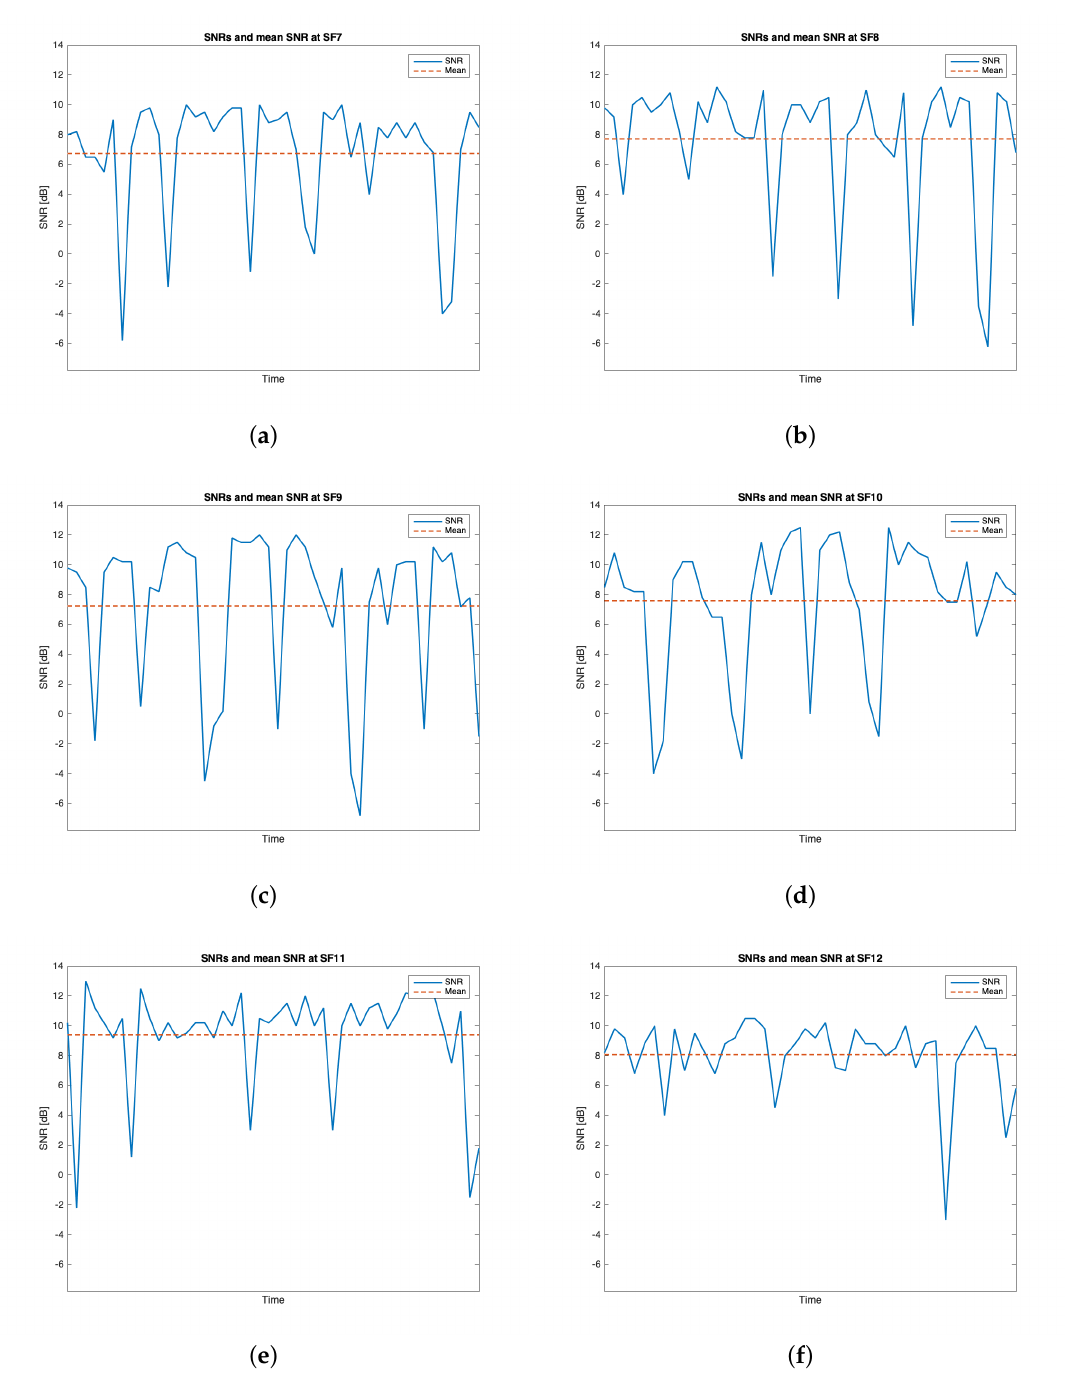
Figure 17. Group #2 SNRs temporal trend: ( a ) SF = 7; ( b ) SF = 8; ( c ) SF = 9; ( d ) SF = 10; ( e ) SF = 11; ( f ) SF =